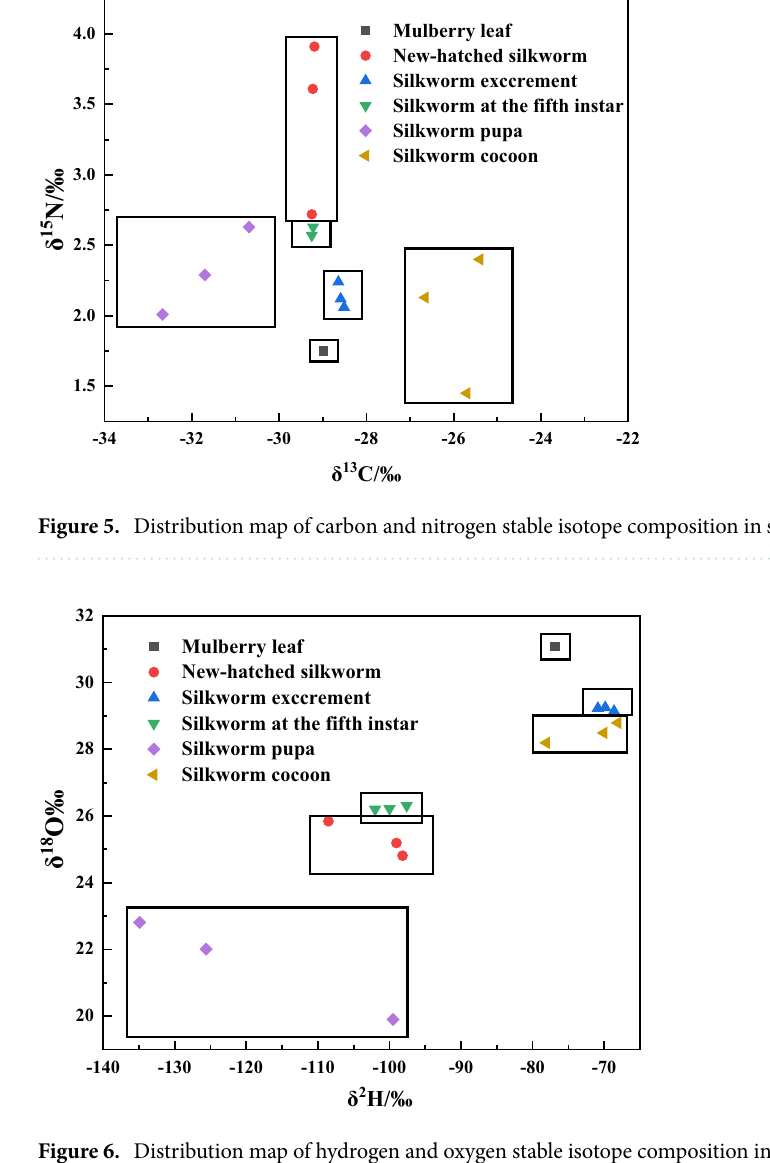
Figure 6. Distribution map of hydrogen and oxygen stable isotope composition in